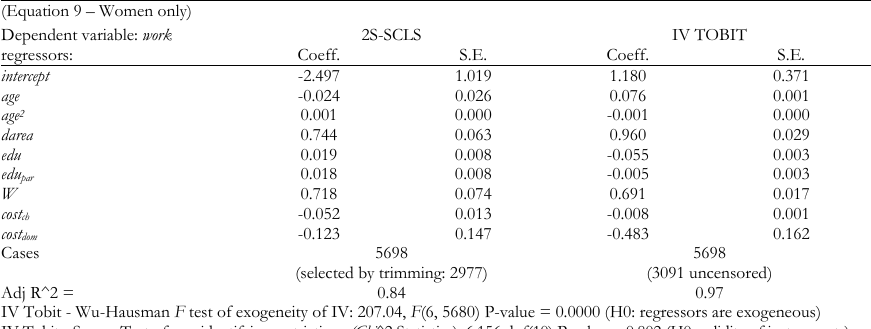
Females paid-work “structural-form” equation estimation